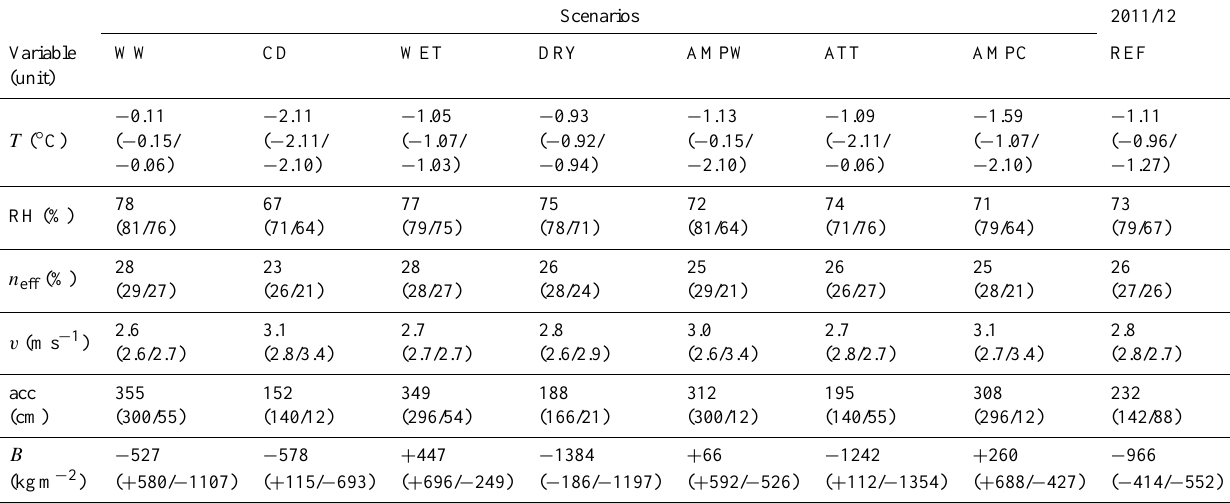
Table 4. Mean air temperature ( T ), relative humidity (RH), effective cloud cover fraction ( n eff ), wind speed ( v ), and accumulation sum for different scenarios and the 2011/12 mass balance year, and for different seasons: annually (wet seasons/dry seasons). Mass balance modelled under each scenario for the 2010 glacier extent is denoted by B ( ± 355kgm − 2